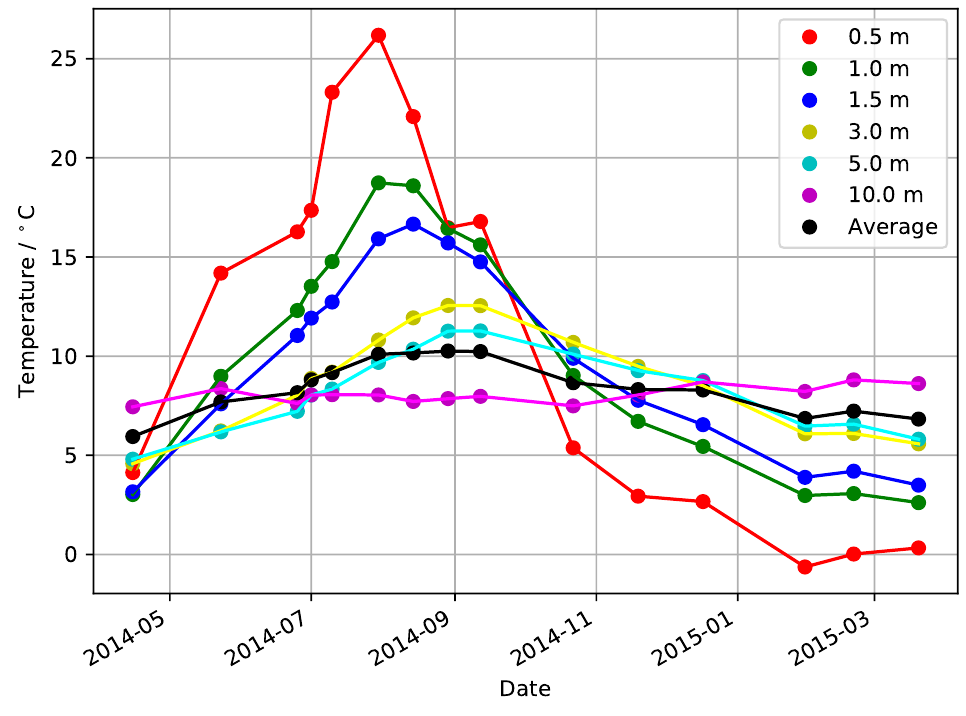
Figure 12. Soil temperatures measured at different depths (0.5 m, 1.0 m, ..., 10 m) and the weighted average temperature of the whole 10 m deep